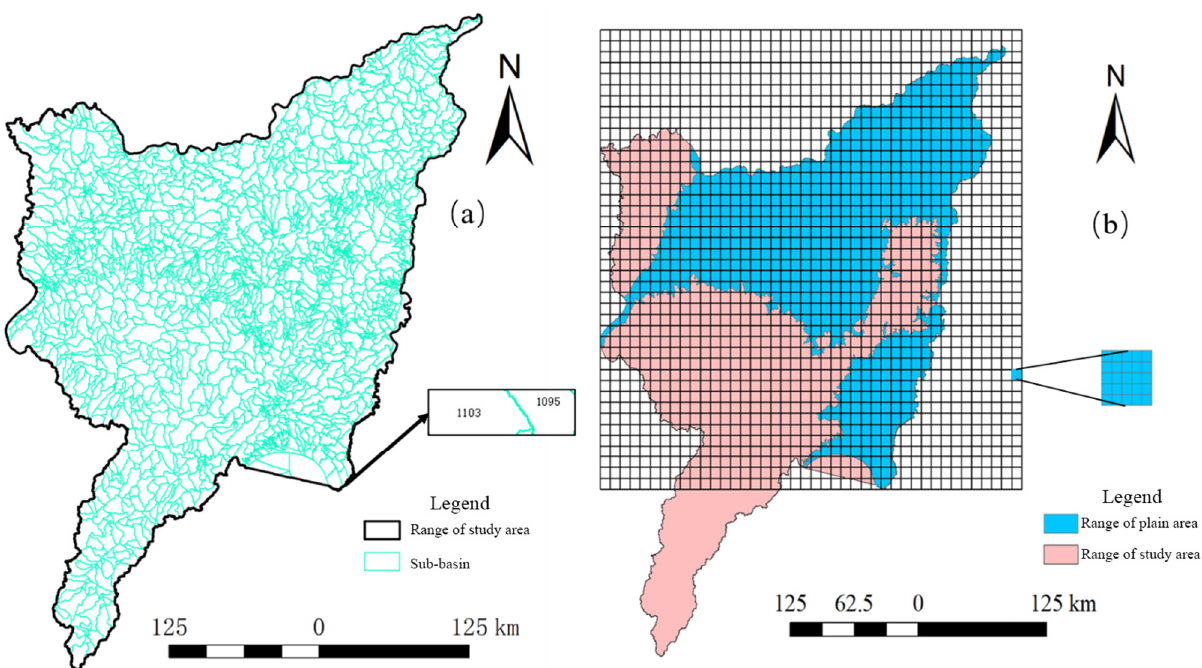
Figure 3. Unit division of the hydrological cycle and groundwater numerical simulation. ( a ) Sub- basins of the Sanjiangping; ( b ) groundwater grid cells in plain areas.